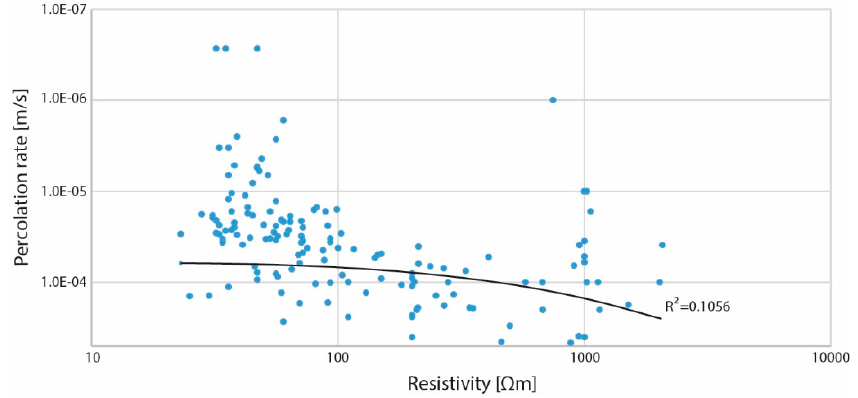
Figure 3. Plot showing the resistivity versus the percolation rate.